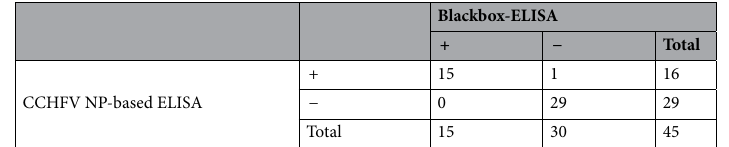
Table 1. Performance of the CCHFV NP-based ELISA compared to Blackbox-ELISA. Sensitivity: 100% (15/15) (95% CI 78.20–100). Specificity: 96.6% (29/30) (95% CI 82.78–99.92). Negative predictive value: 100% (29/29) (95% CI 88.06–100). Positive predictive value: 93.8% (15/16) (95% CI 69.76–99.84). Agreement rate: 97.8% (44/45) (95% CI